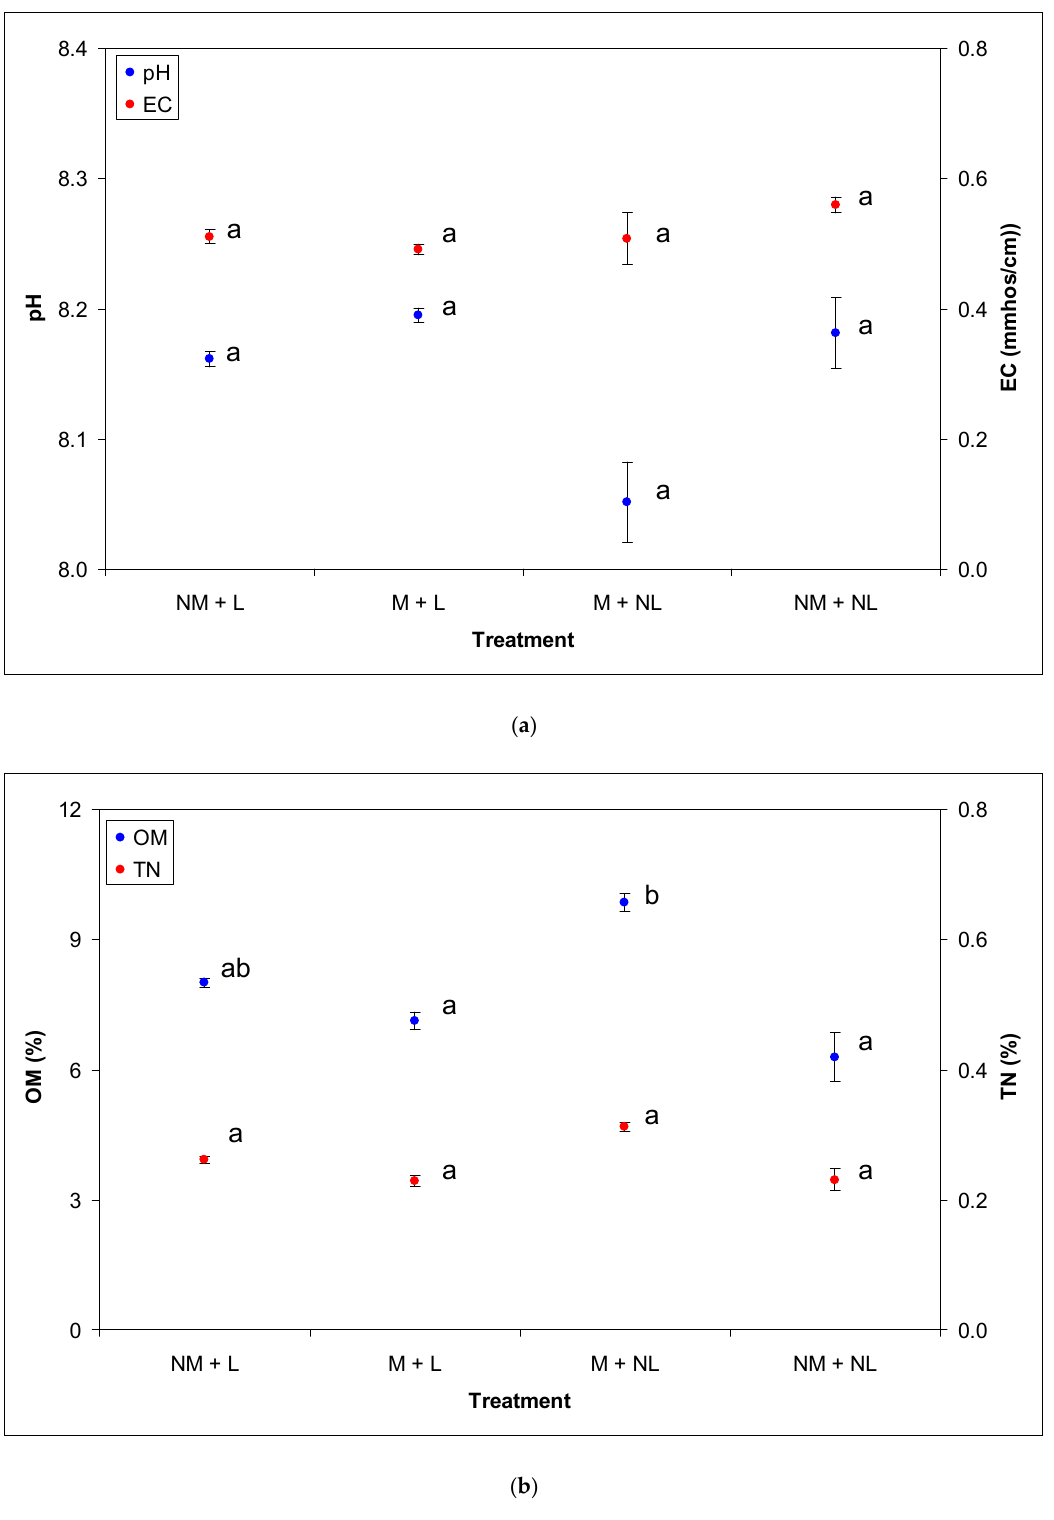
Figure 5. Main chemical properties of soils (mean ± standard deviation) supporting growth of Pinus halepensis Mill. in plots subjected to four treatments in Sierra de Los Donceles forest (Liétor, Castilla La Mancha, Spain). pH ( a ) and OM ( b ). Different letters indicate significant differences among treatments according to the LSD test ( p < 0.05). Legend: M + L = Mulching + Logging; NM + L = No Mulching + Logging; NM + NL = No Mulching + No Logging; M + NL = Mulching + No Logging; EC = electrical conductivity; OM = organic matter; TN = total